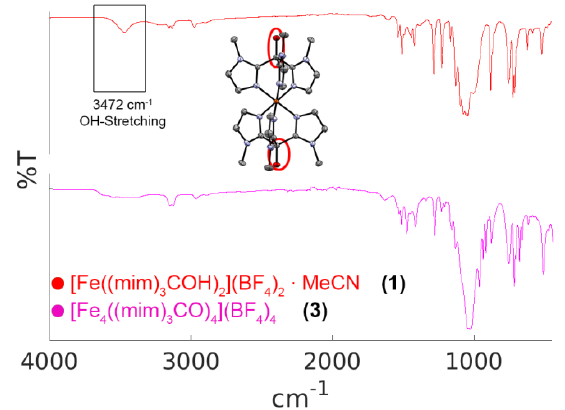
Figure 11. Comparison of the mid-range infrared spectra of 1 ( top ) and 3 ( bottom ).